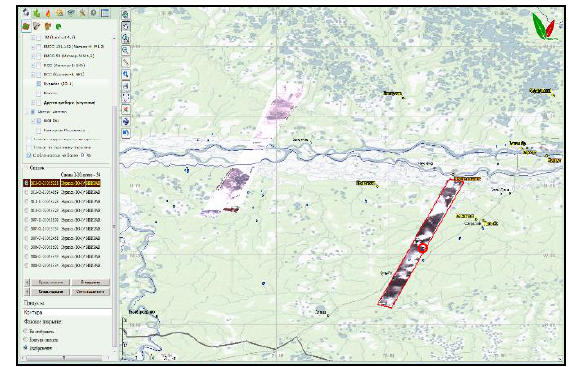
Figure 7. VEGA visualizing and subselection